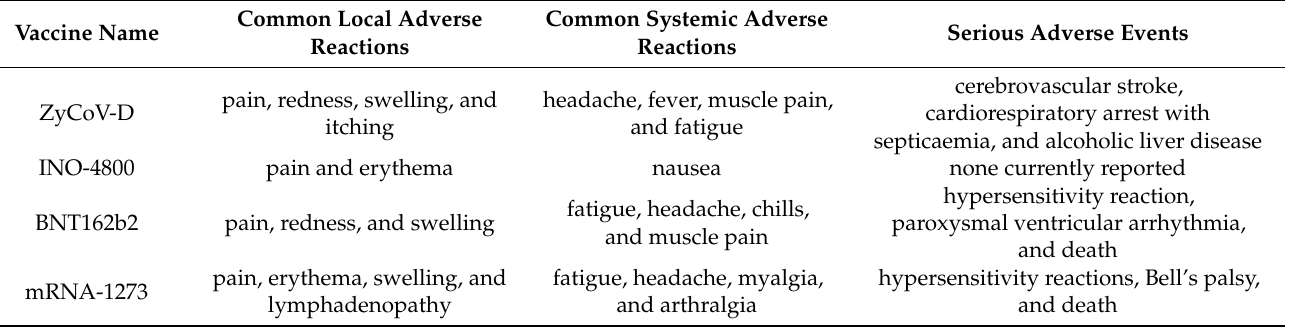
Table 2. The common adverse reactions to COVID-19 nucleic acid